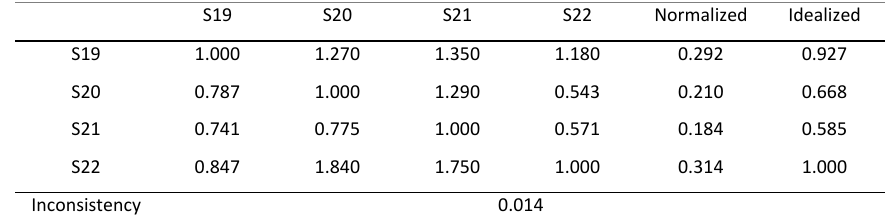
Table 9. Pairwise comparison matrix of accessibility sub-criteria Table 9: Pairwise comparison matrix of accessibility sub-criteria